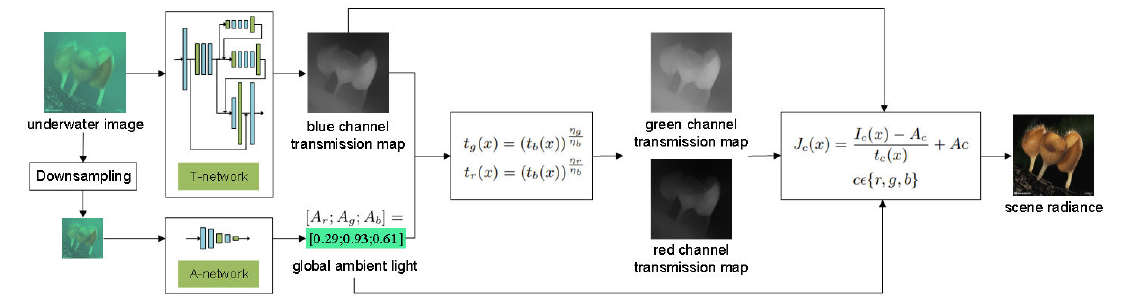
Figure 3. The architecture of our